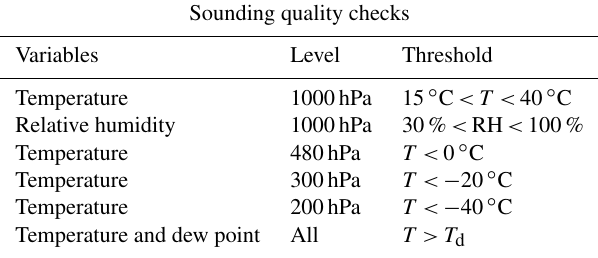
Table 2. Total number of quality controlled radiosonde observations for each of the upper-air sounding sites. To increase the number of data points, each variable was given independent consideration during the quality control